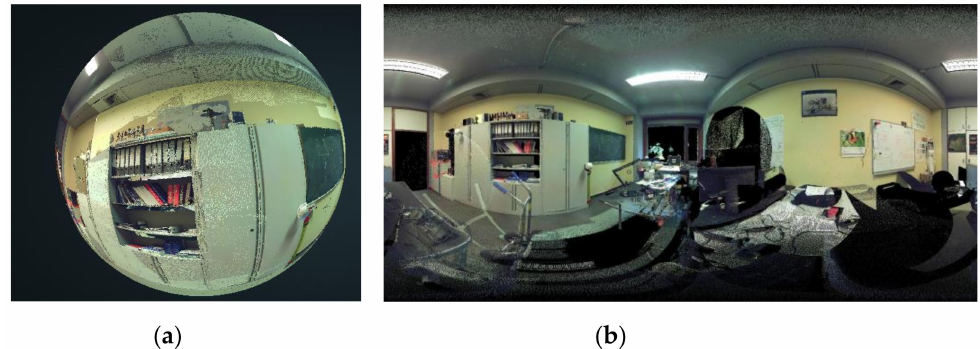
Figure 5. ( a ) Result of the spherical projection visualised on Potree; ( b ) first panoramic image after the equirectangular cylindrical projection. Adapted from ref.